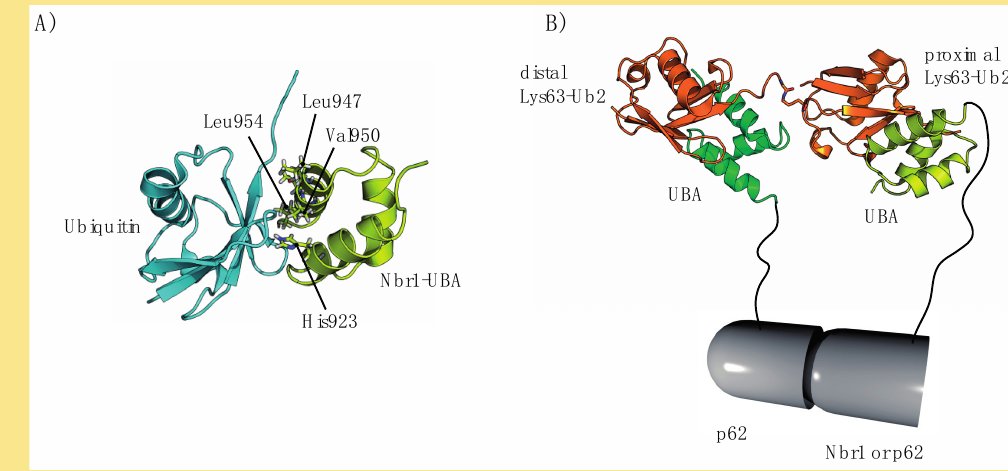
Figure II. ( A ) Structure of the Nbr1-UBA domain in complex with Ub (PDB code 2MJ5), showing the UBA- interacting residues. ( B ) Putative model explaining the affinity of p62 or Nbr1 for Lys63-Ub2 chains. Upon binding via the PB1 domain, dimerization may favor the binding of the p62- or Nbr1-UBA domains to Lys63-Ub2. The structure of the Nbr1 UBA /Ub complex has been superimposed on the structure of Lys-Ub2 (PDB code